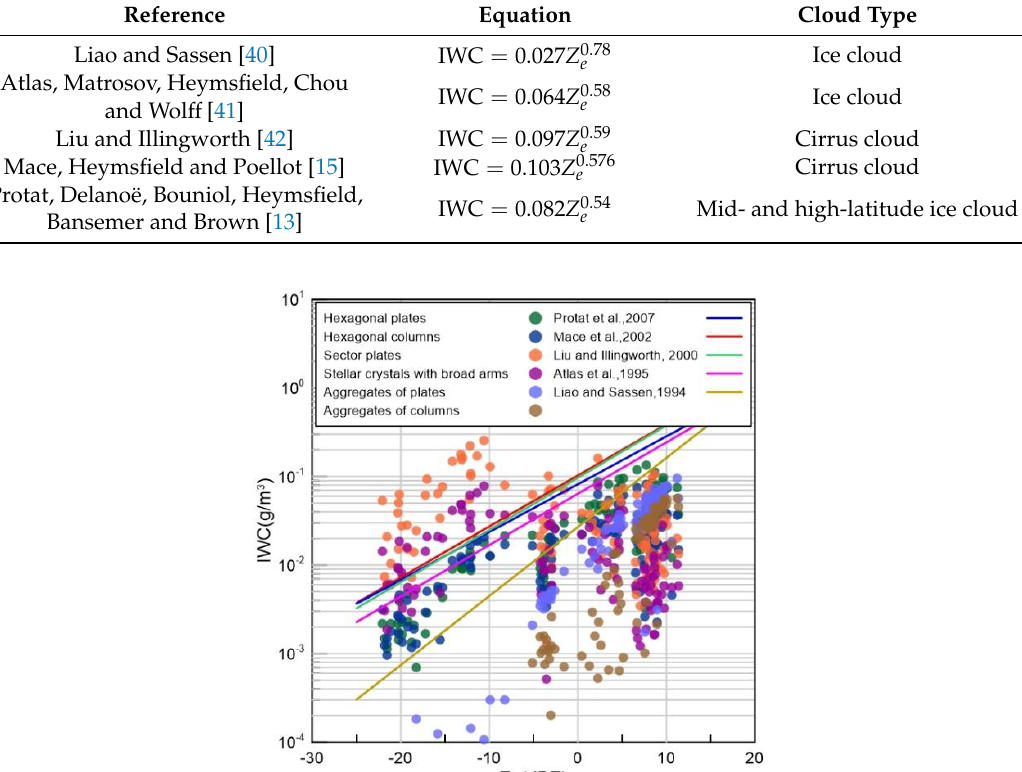
e and ice water content